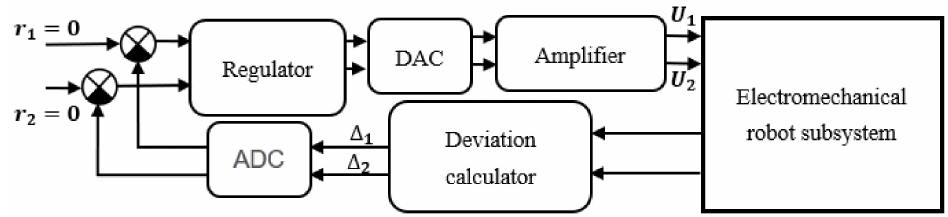
Figure 7. Structural diagram of the automatic robot’s motion control system.